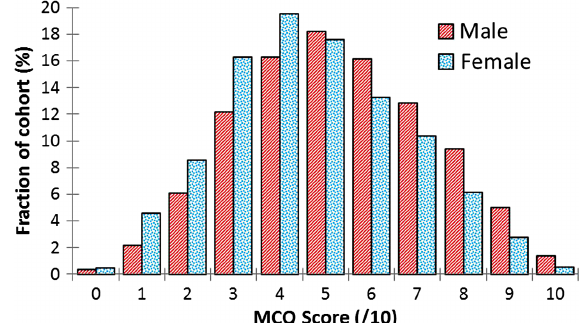
FIG. 1. Frequency distribution of male (red or striped) and female (blue or dotted) MCQ score (out of ten) for all ASOEs from 2007 to 2014.